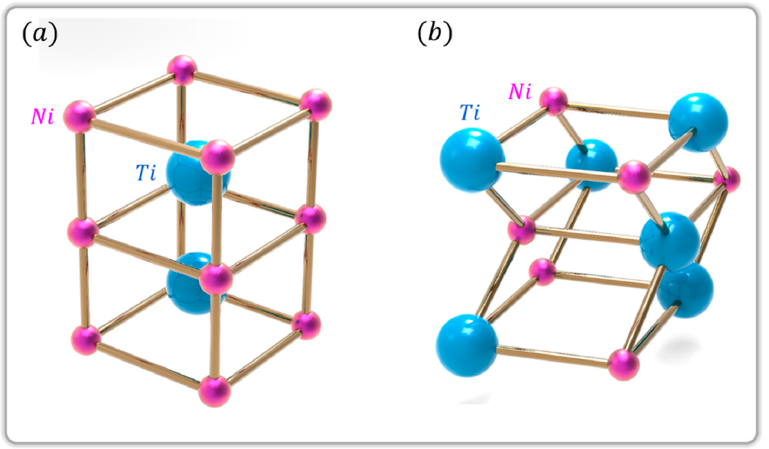
Figure 4. Crystal structure phases of NiTi displaying ( a ) B2 austenitic phase, and ( b ) B19 ′ martensitic phase (Designed by T.-H.K.).